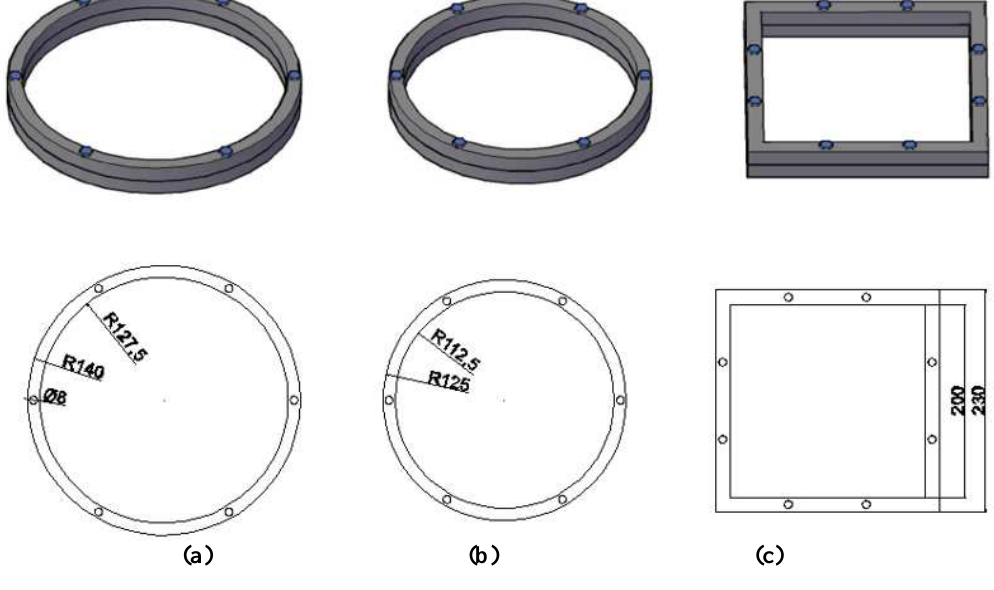
Fig. 4. Types of blank holder that used in this